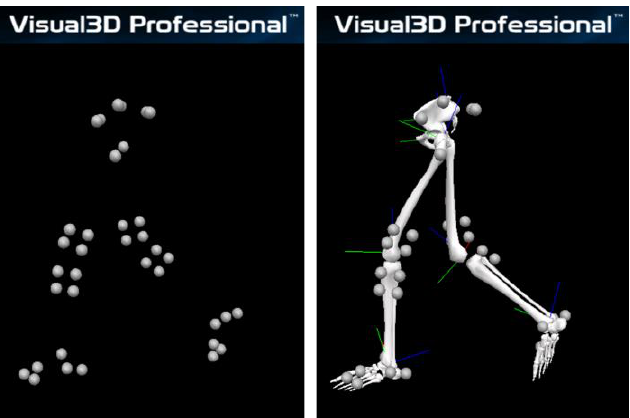
Figure 3. Kinematics analysis using an optical motion analysis system. Each segment coordinate system was defined from the marker coordinates, and the knee joint angle was calculated from the relative positions of the thigh and shank segments.